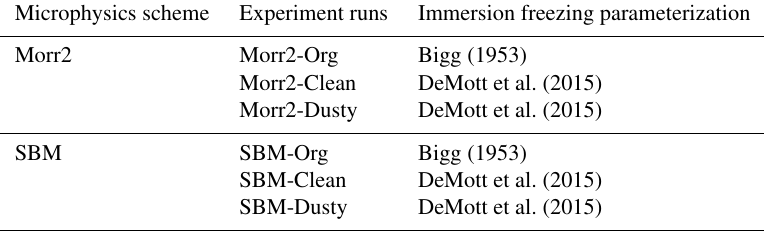
Table 1. Six numerical runs with different settings of the immersion freezing parameterization are considered in this study. The default Morrison and SBM schemes in WRFv4.2.0 with Bigg (1953) immersion freezing parameterization are used as control runs (Morr2-Org and SBM-Org). Four simulations with modified Morr2 and SBM schemes were run with different dust profiles simulated by the GEOS-Chem model, respectively.